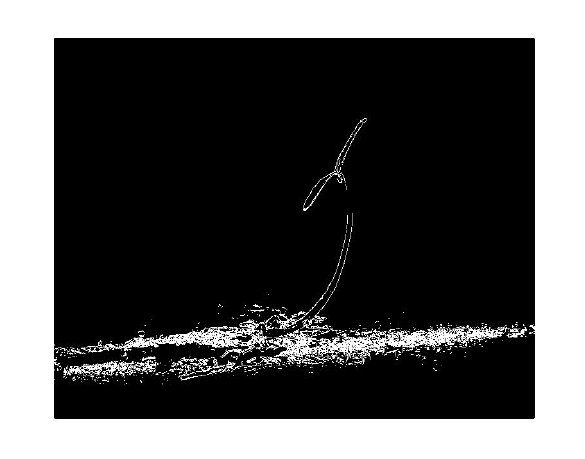
Figure 6.2 Segmented Bird Image